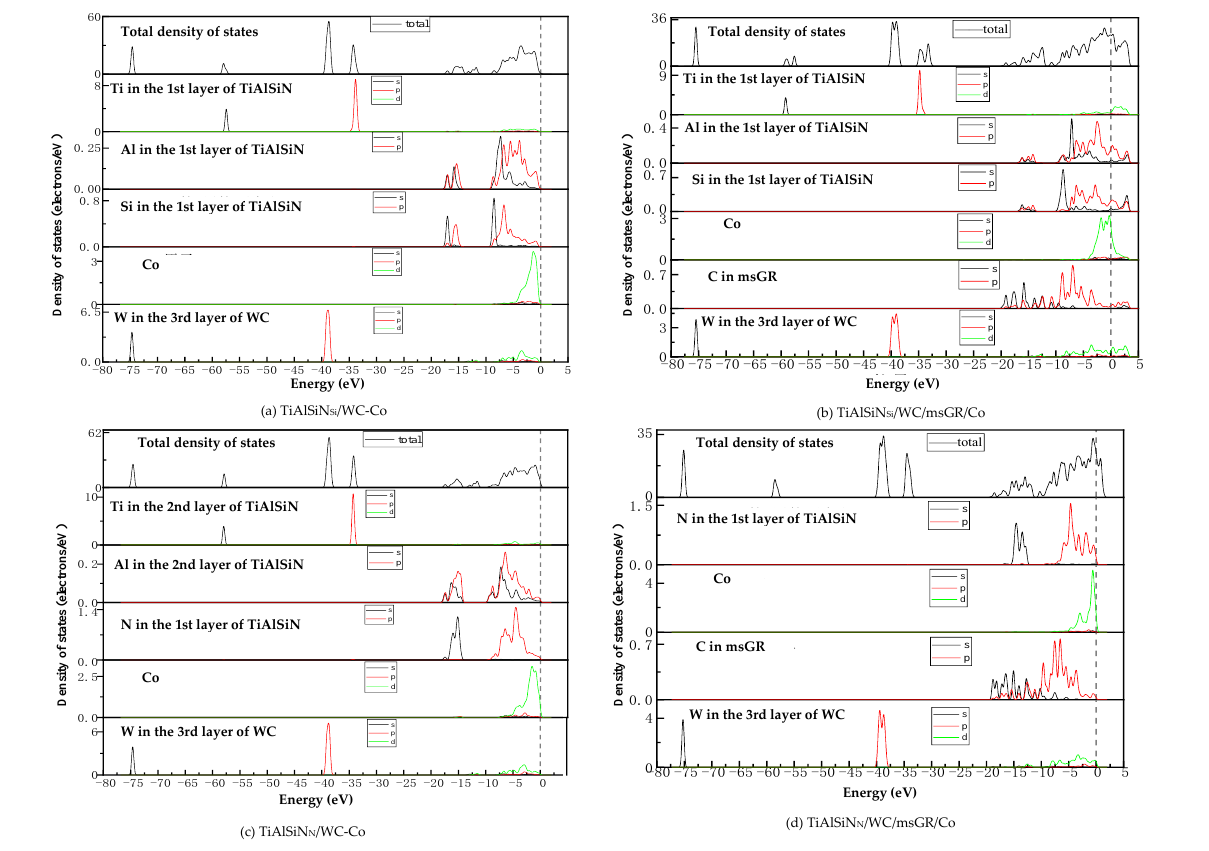
Figure 15. TDOS and PDOS of the interface models without doping GR and with matrix doped with msGR.